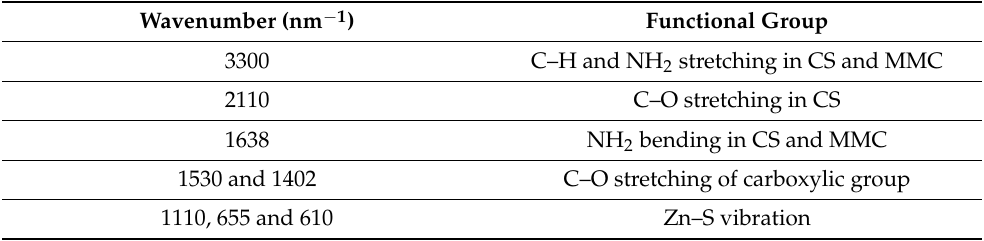
Table 1. Absorption peaks for different functional groups in